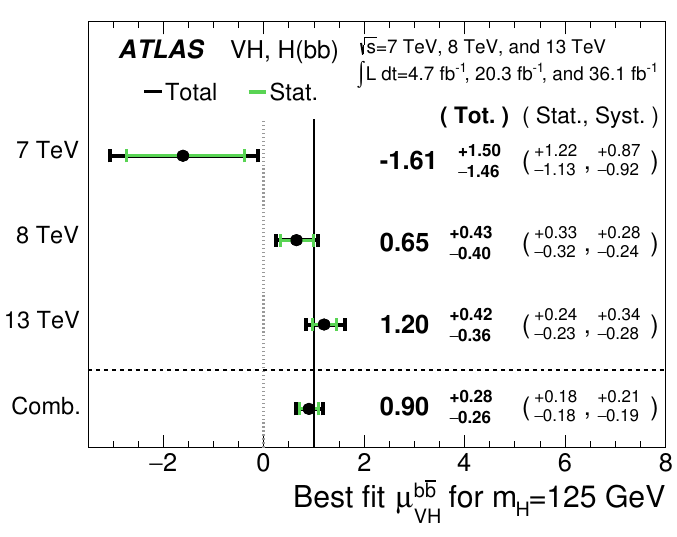
Figure 12 . The (cid:12)tted values of the Higgs boson signal strength parameter (cid:22) for m H = 125 GeV separately for the 7 TeV, 8 TeV and 13 TeV datasets and their combination.